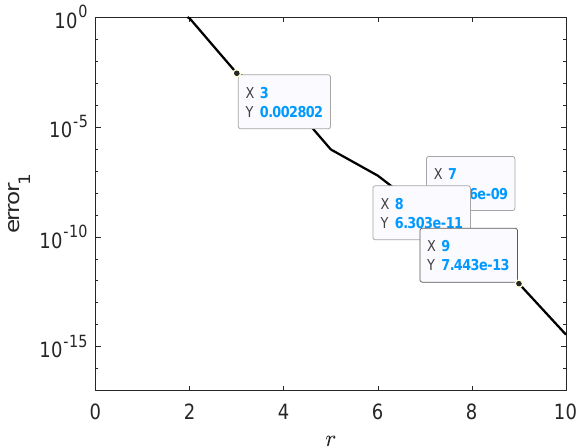
Figure 38. Convergence graph of y 1 .